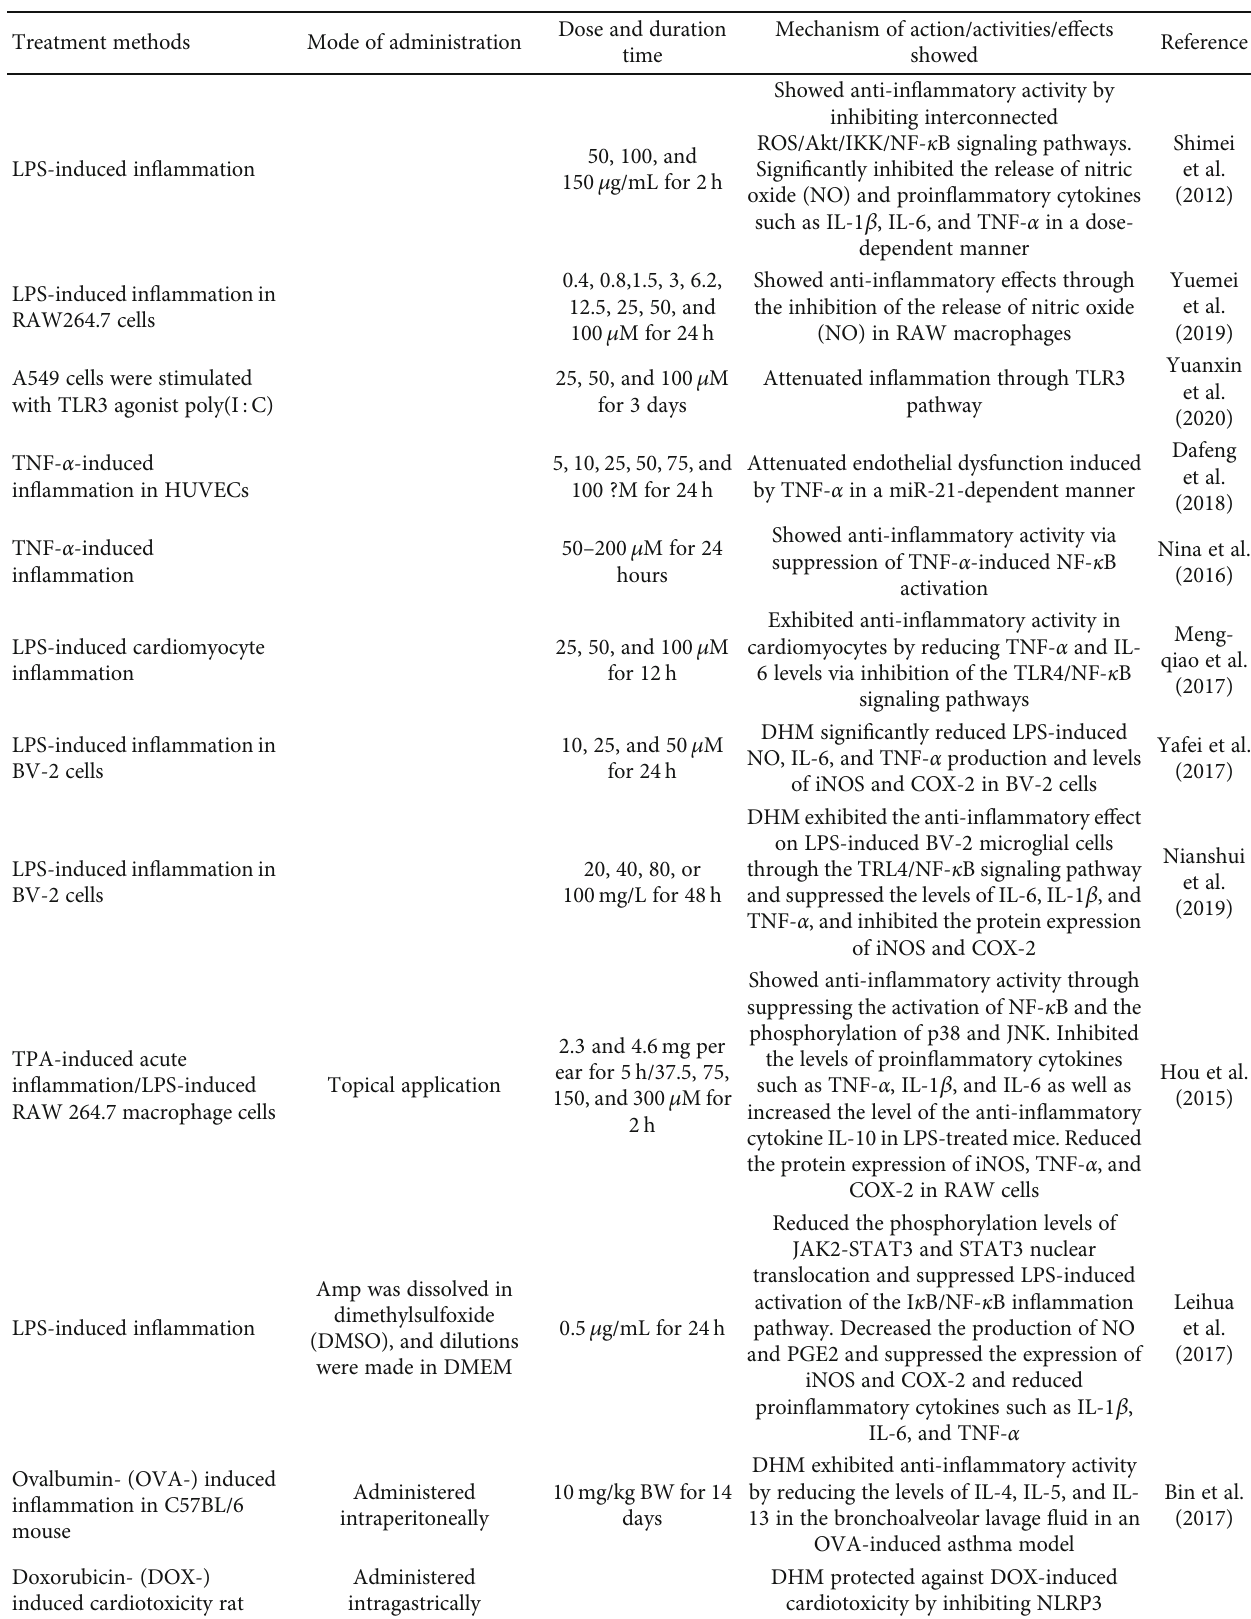
Table 3: Anti-in fl ammatory activities and mechanisms of the action of